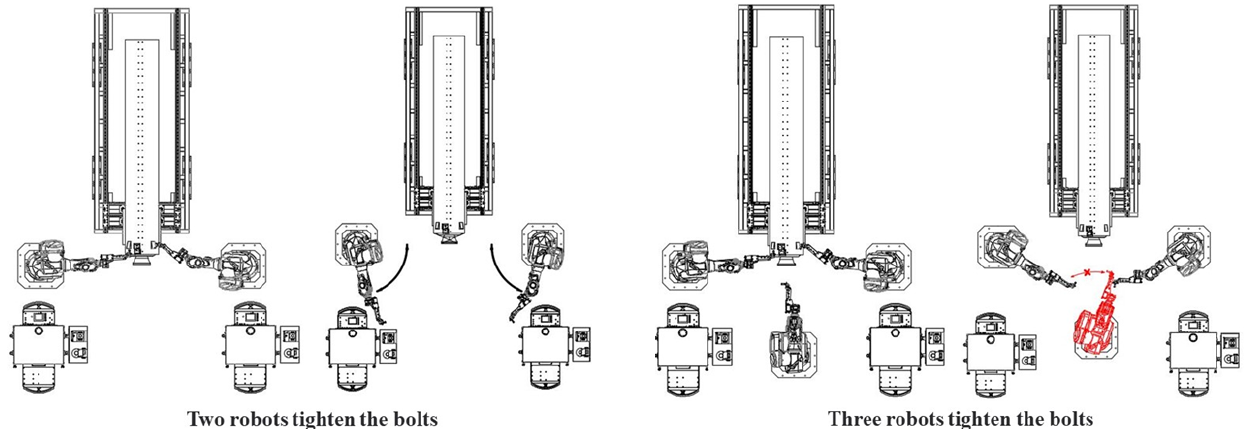
Figure 12. Schematic of multiple robots tightening